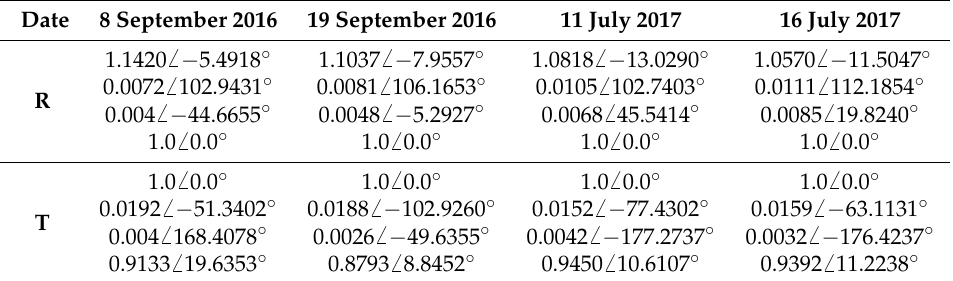
Table 4. The extracted polarimetric distortion matrices of Freeman’s algorithm in [2].